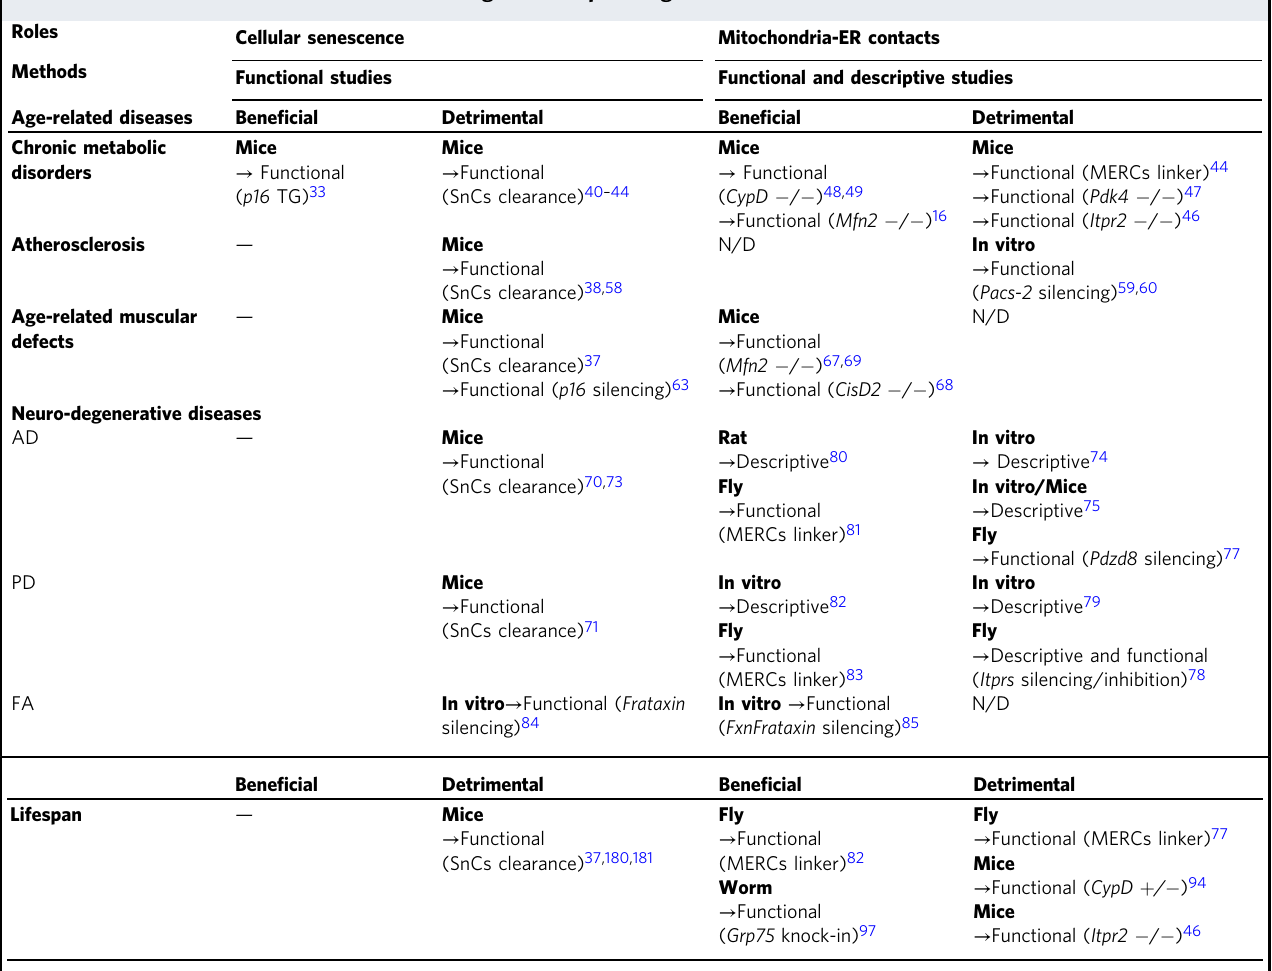
Table 1 MERCs roles in senescence-associated age-related